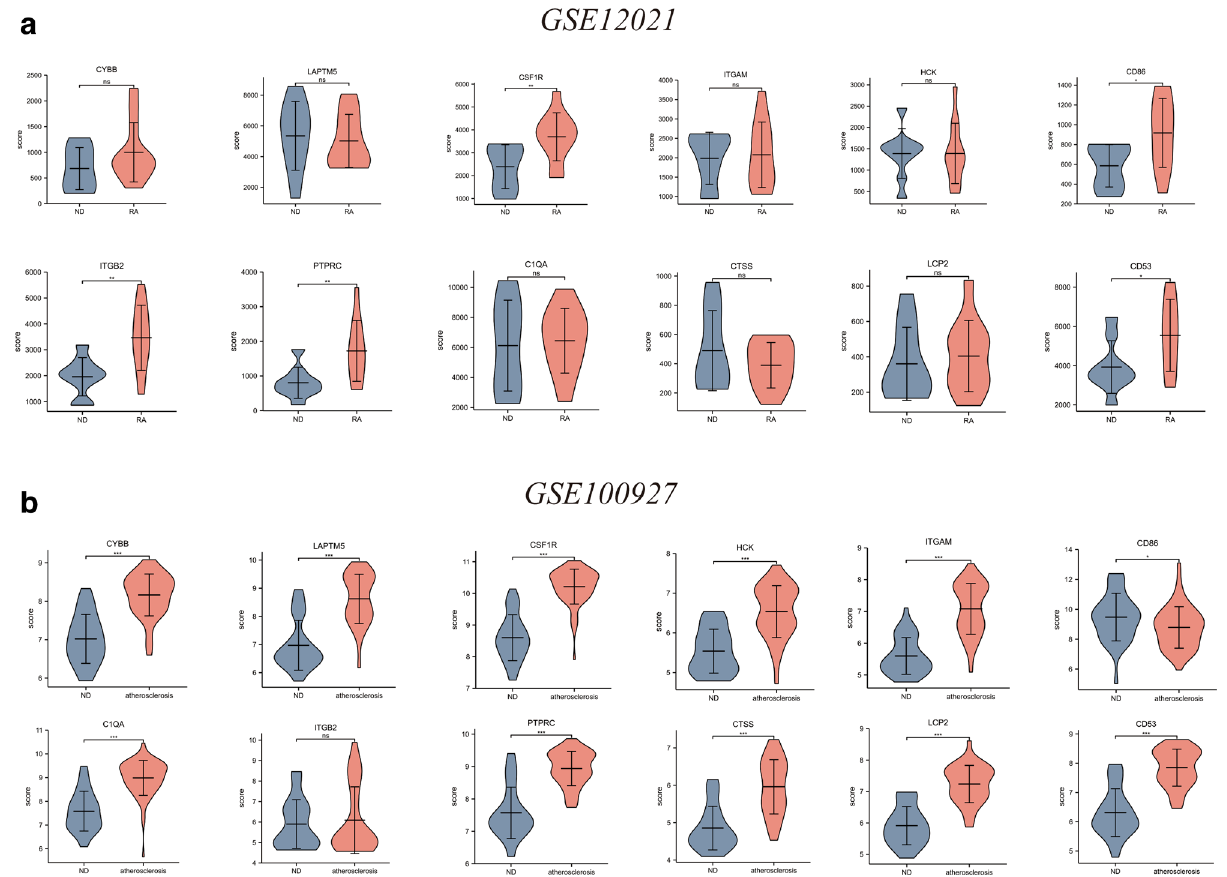
Figure 5. Expression level of hub gene in GSE12021 and GSE100927. ( a ) The verification of hub genes in GSE12021. ( b ) The verification of hub genes in GSE100927 The comparison between the two sets of data with the mean T test. RStudio (https:// www.R- proje ct. org) was used in statistical analysis. P value < 0.05 was considered statistically significant. *P < 0.05; ***P <